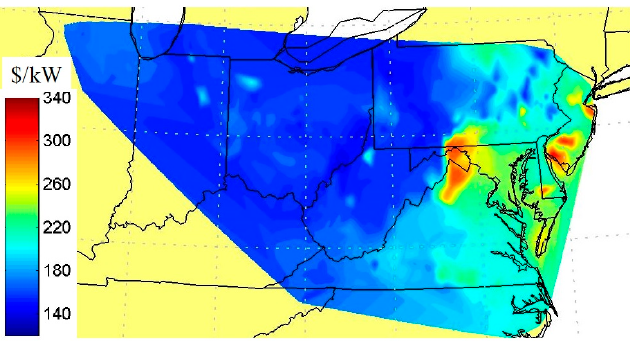
Figure 17. The variation of potential revenue in RTM for 2008 with 7395 PJM node locations.